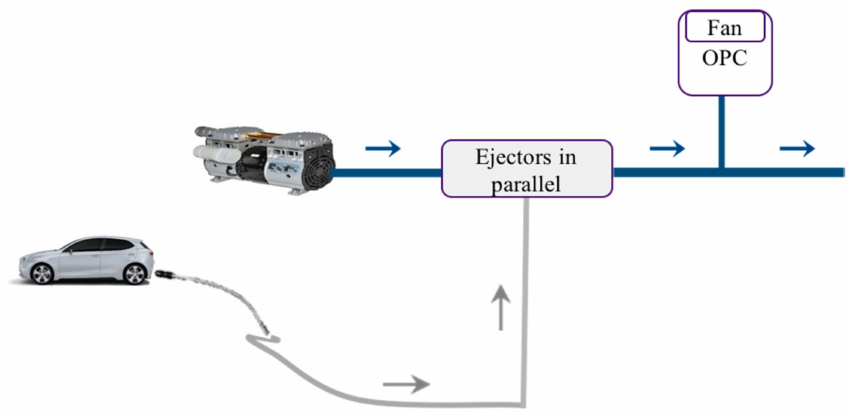
Figure 6. Final layout of the optical particle counter (OPC) perpendicular to the main flow